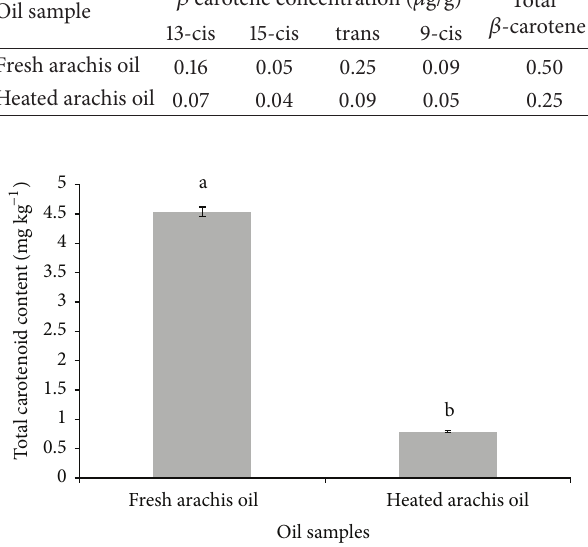
Figure 7: Effect of thermal oxidation on total carotenoid content of arachis oil. Total carotenoid contents are expressed as mean ± standard deviation ( 𝑛 = 3 ). Bars with different alphabets are significantly different ( 𝑃 < 0.05